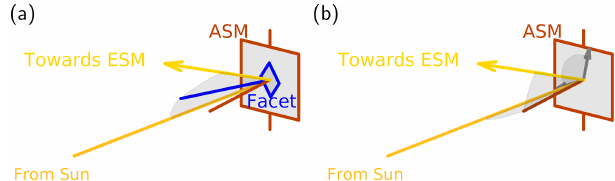
Figure 3. (a) Only the ASM diffuser facets with an orientation for a specular reflection towards the ESM mirror contribute to the mea- sured signal. The orientation of these facets is calculated from the direction towards the Sun and the ESM mirror using analytic ge- ometry. (b) The diffuser sensitivity depends on the incident angles of the solar direction and the direction towards the ESM mirror and the azimuth angle between these two.